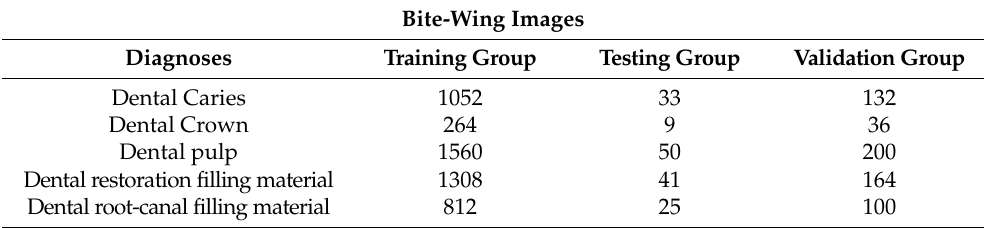
Table 1. Training, testing, and validation groups on bite-wing images for five different dental